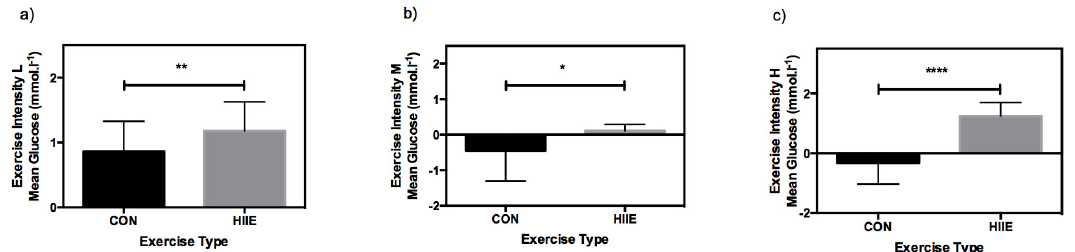
Figure 5. Mean differences in glucose response (CGM vs. BG) in comparison of CON (black bars) and HIIE (grey bars) given as means ± SD. Levels of significance for the different exercise intensities were: L ( a ) (** p = 0.001), M ( b ) (* p = 0.01), and H ( c ) (**** p < 0.0001).